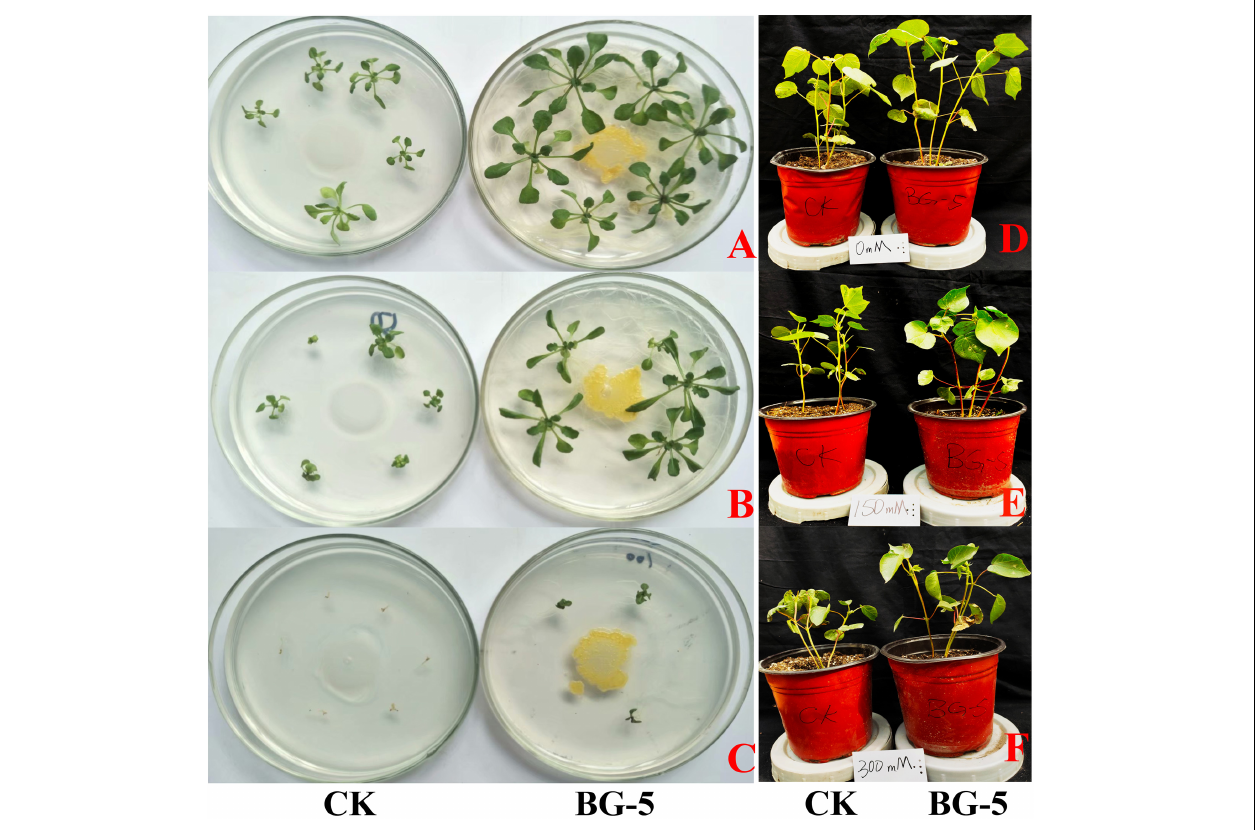
FIGURE 5 | Effect of BG-5 on the growth of Arabidopsis thaliana and cotton under salt stress (30 days and 45 days, respctively). (A) A. thaliana treated with 0 mmol · L − 1 NaCl; (B) A. thaliana treated with 50 mmol · L − 1 NaCl; (C) A. thaliana treated with 50 mmol · L − 1 NaCl; (D) cotton treated with 0 mmol · L − 1 NaCl; (E) cotton treated with 150 mmol · L − 1 NaCl; (F) cotton treated with 300 mmol · L − 1 NaCl. Left side is CK, no-inoculated with BG-5; right side is experienment group, inoculated with